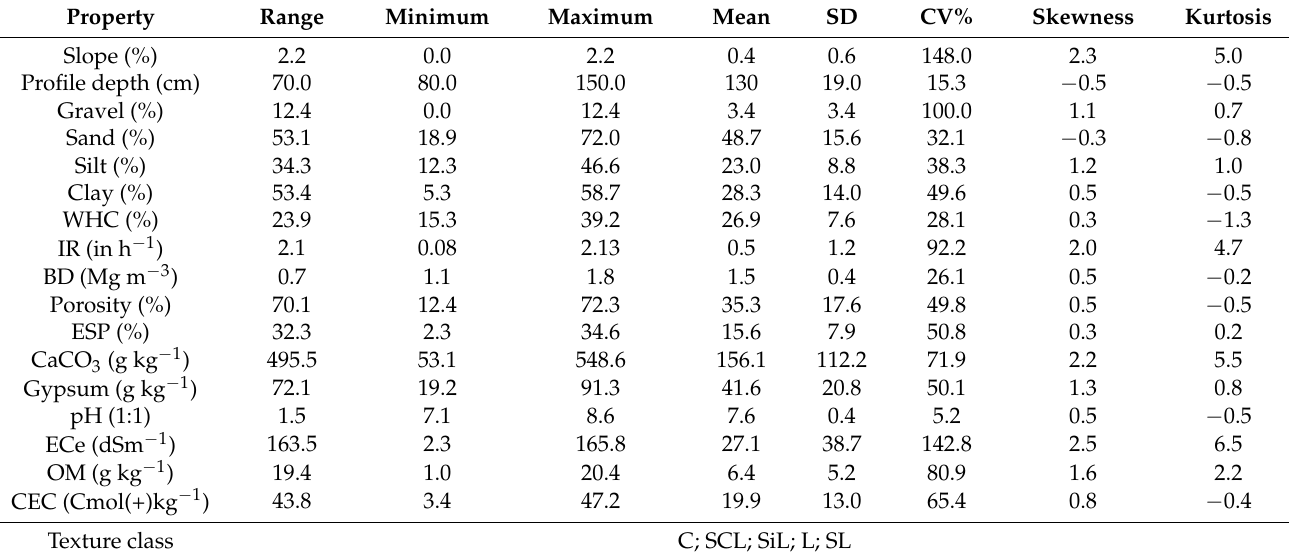
Table 2. Descriptive statistics of the weighted mean of the studied soil profiles properties ( n = 211).